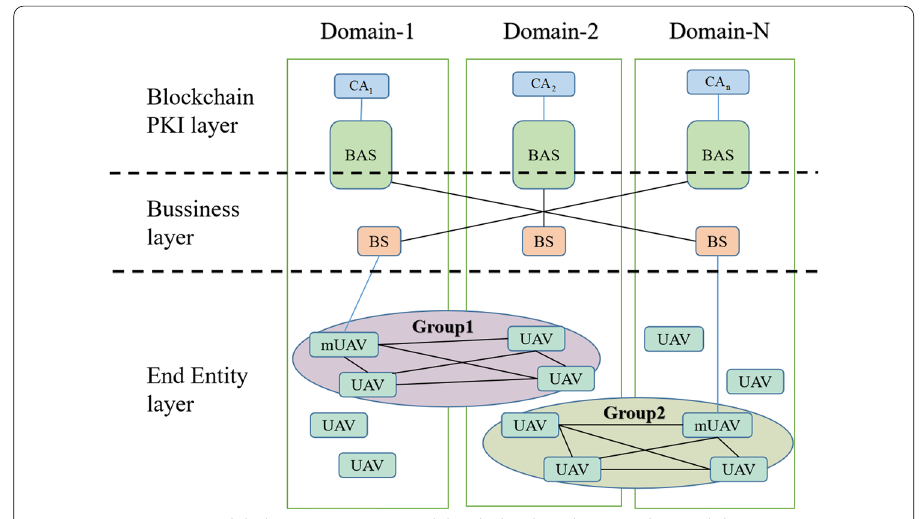
Fig. 1 ToAM system model. The ToAM system model includes three layers and several domains. UAV in different domains can dynamically build a drone group with the help of